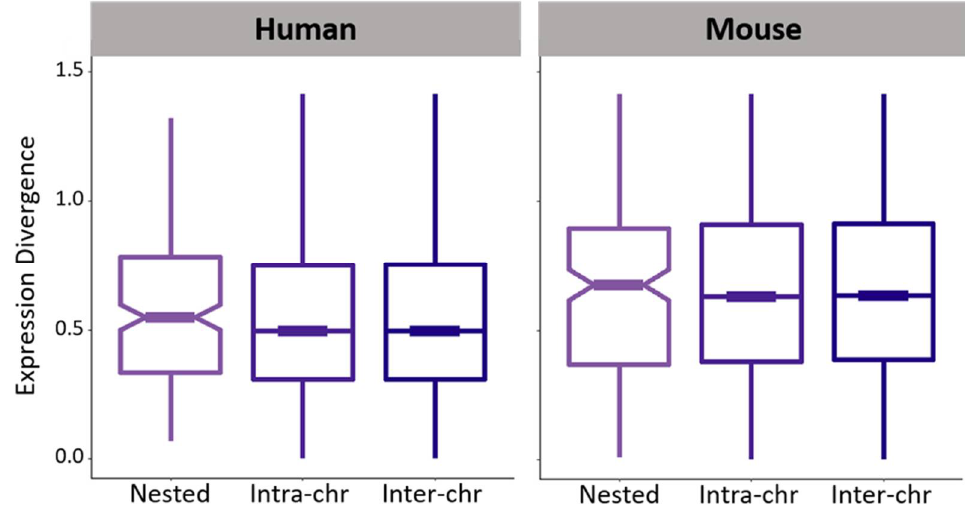
Figure 2. Expression divergence between nested, intra-chromosomal, and inter-chromosomal protein-coding genes. Distributions of Euclidian distances across seven tissues between gene pairs in human (left) and mouse (right). None of the pairwise differences between distributions are statistically significant (see Materials and Methods for details).